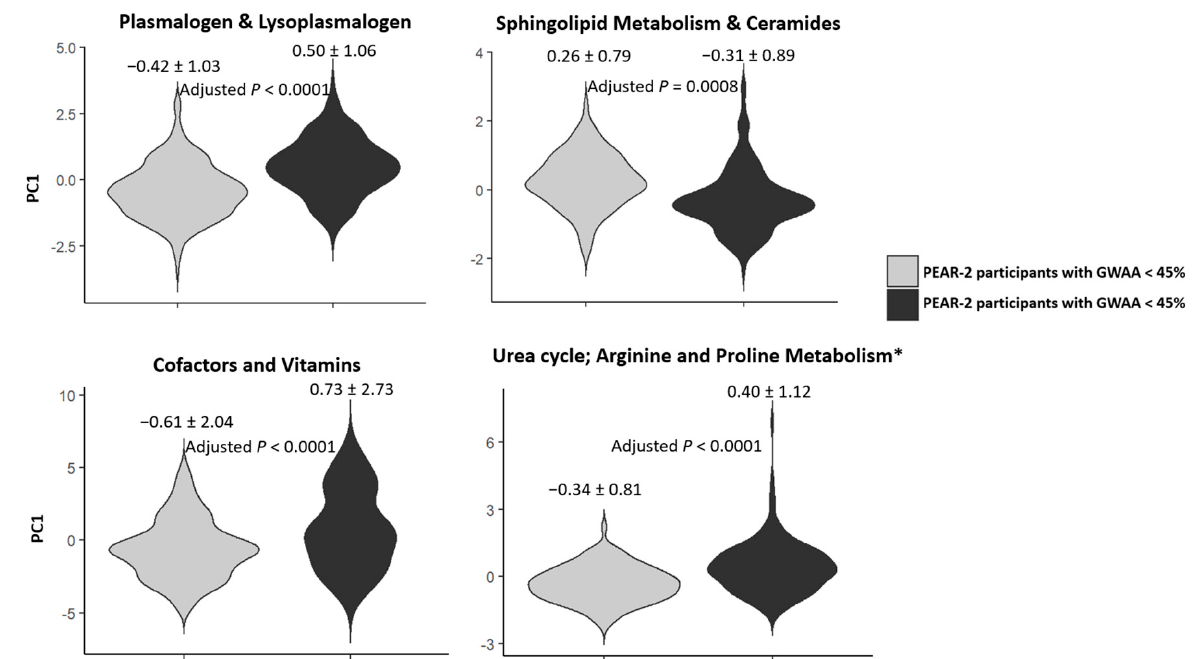
Figure 3. Violin plots comparing PC1 values of each of the 4 replicated metabolic clusters between PEAR-2 participants with GWAA < 45% and those with GWAA ≥ 45%. Gray bars represent PEAR participants with GWAA < 45%, whereas black bars represent PEAR participants with GWAA ≥ 45%. The adjusted p -values (Bonferroni-corrected) were calculated using multivariable linear regression models adjusted for age, sex, recruitment site, baseline log-transformed PRA and batch effect. * The metabolic cluster (urea cycle; arginine and proline metabolism) with highly skewed PC1 distribution was flagged. Abbreviations: PC, principal component; PEAR, Pharmacogenomic Evaluation of Antihypertensive Responses; GWAA, Genetic West African